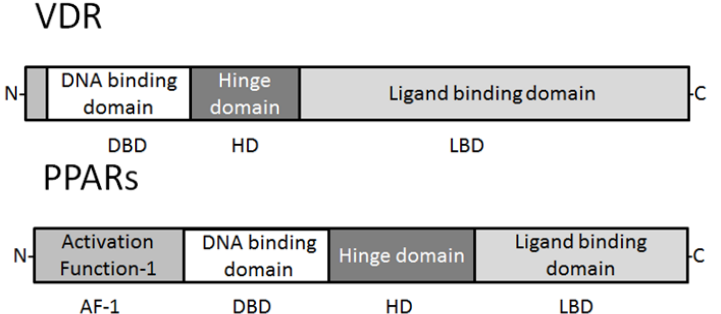
Figure 1. Schematic structure of VDR and PPAR protein. The predicted consensual important domain structures for VDR and PPAR are depicted, which are common in some species. AF-1 = activation function-1, DBD = DNA binding domain, HD = hinge domain linking DBD and LBD, LBD = C-terminal ligand binding domain. Note that the sizes of protein are modified for